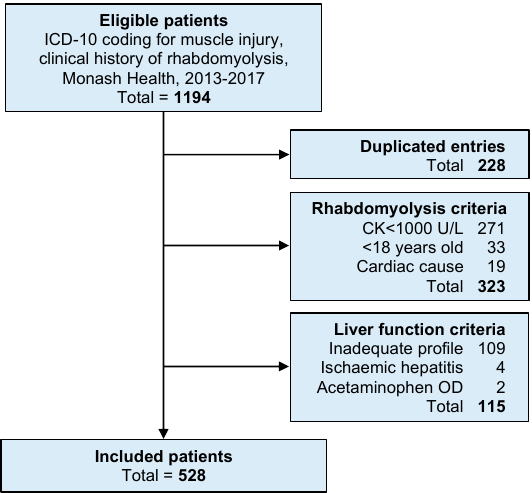
Figure 1. Study flow diagram. This flow chart shows the patient selection based on the International Classification of Diseases 10th revision (ICD-10) and reasons for exclusion from the study. The majority of patients were excluded for a peak creatine kinase (CK) below 1000 U / L or an inadequate liver biochemistry profile which could not be matched to the CK level. Table 1. Characteristics of included patients ( n = 528).